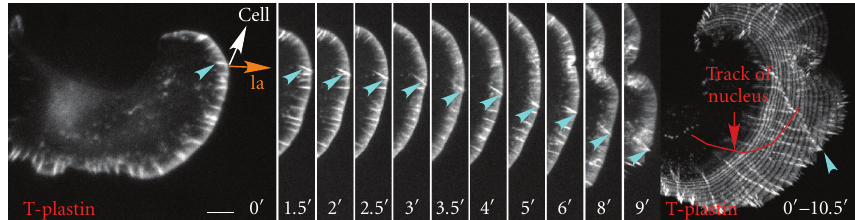
T-plastin Figure 8: The lateral motion of filopodia is related to the direction of cell migration. Live cell time-lapse of a cell transfected with mCherry-T-plastin. Turquoise arrowheads indicate the lateral filopodia. The golden arrow shows the direction of movement of the original lamellipodium and the white arrow shows the direction of eventual cell migration. The last panel shows a Z-projection of all the images to visualize the track of the nucleus (red line) and the track of the lateral filopodium. The lateral filopodium moves in a direction opposite to the direction of cell turning. The entire movie can be found in Supplementary Data, Movie 9. Scale Bar 10 μ